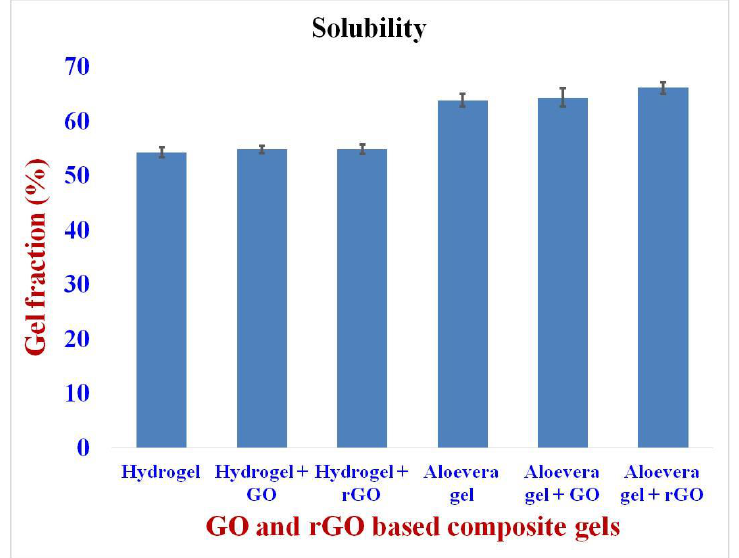
Figure 6. Solubility of GO and rGO-based composite gels.